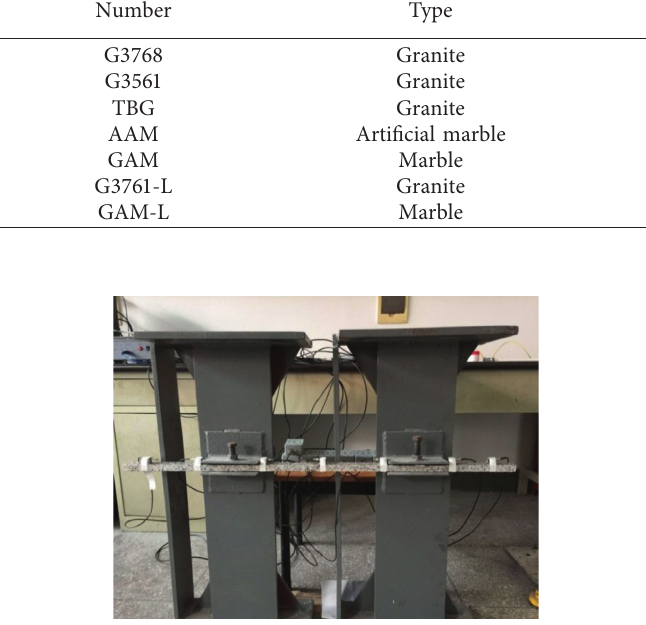
Figure 1: The sensors network layout for the rod-shaped rock samples. Table 2: The coordinates of sensors on the rod-shaped rock samples.